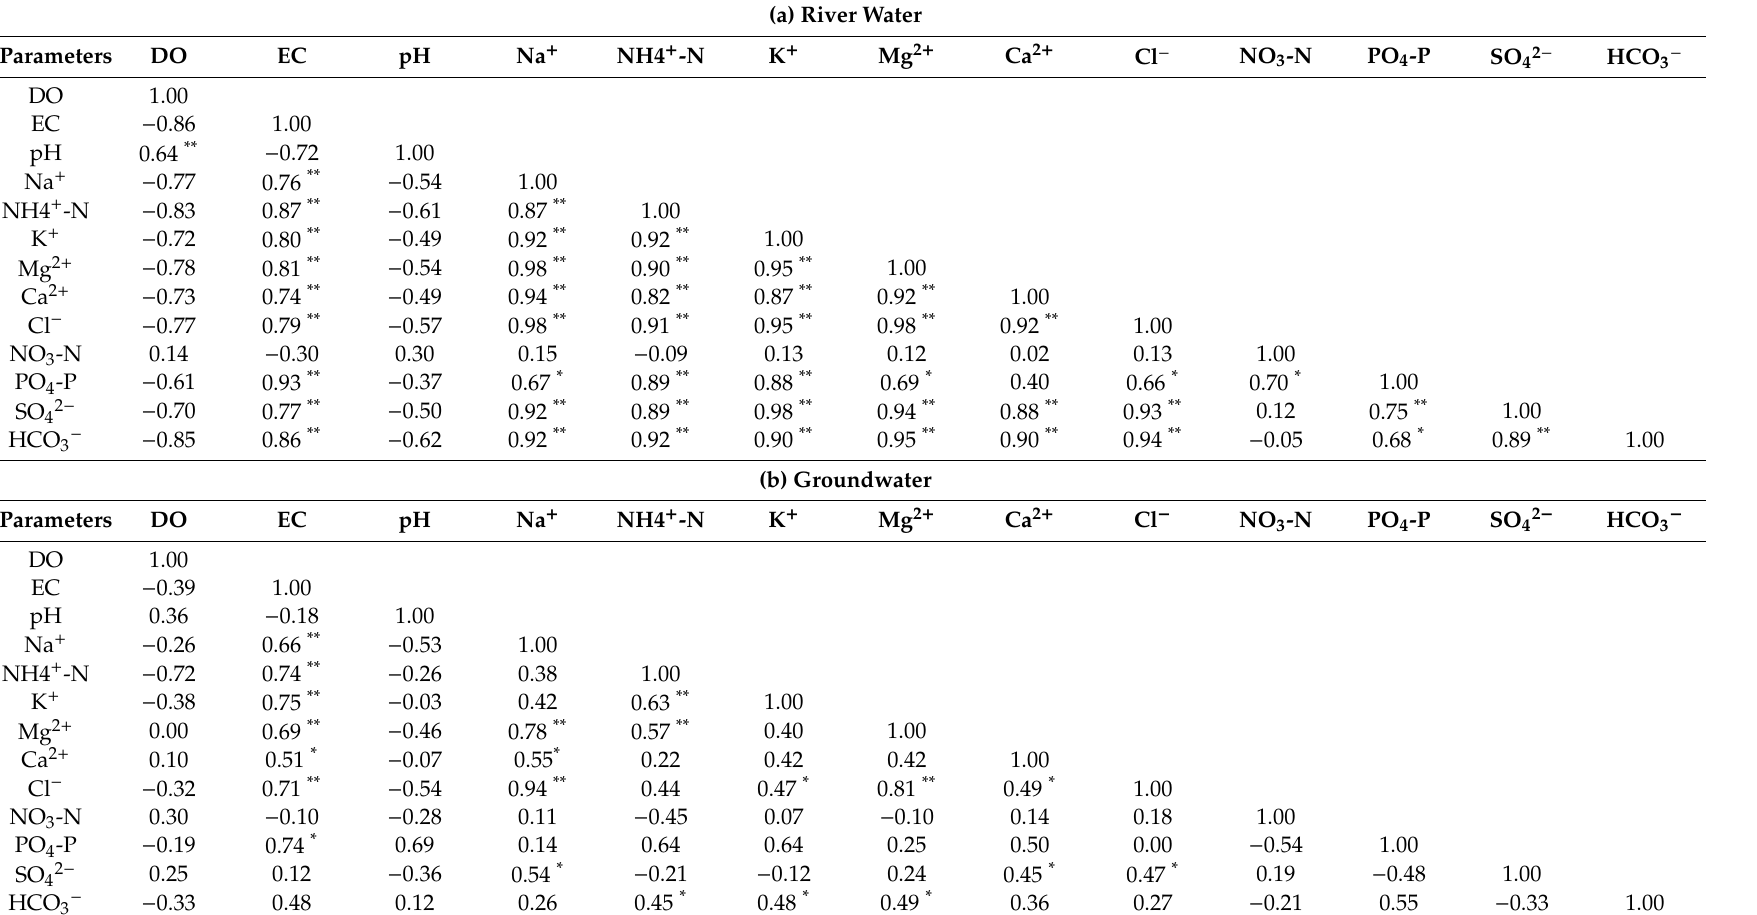
Table 2. Correlation matrix of di ff erent chemical